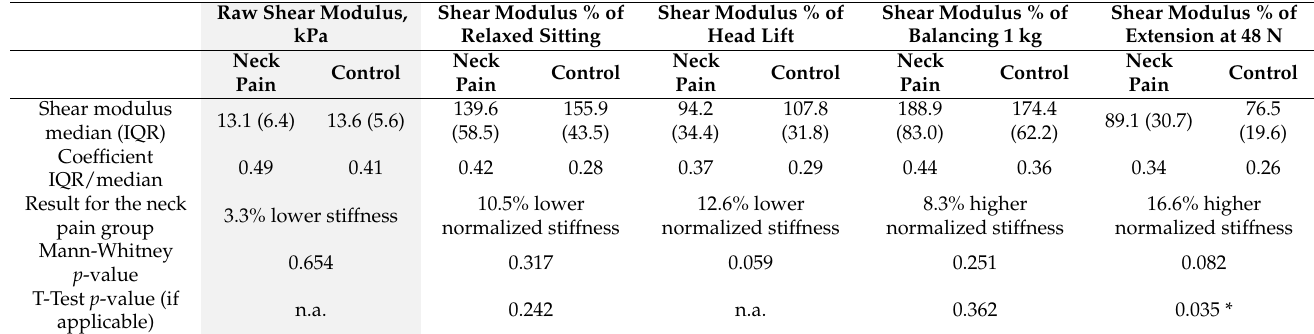
Table 1. Raw and normalized neck muscle shear modulus averaged over tasks per group, coefficients of within-group variation, change of variation relative to the raw measurements, the main result of the group comparison, and p -values for differences between groups. Abbr.: IQR, interquartile range; n.a. not applicable; * significant at p <